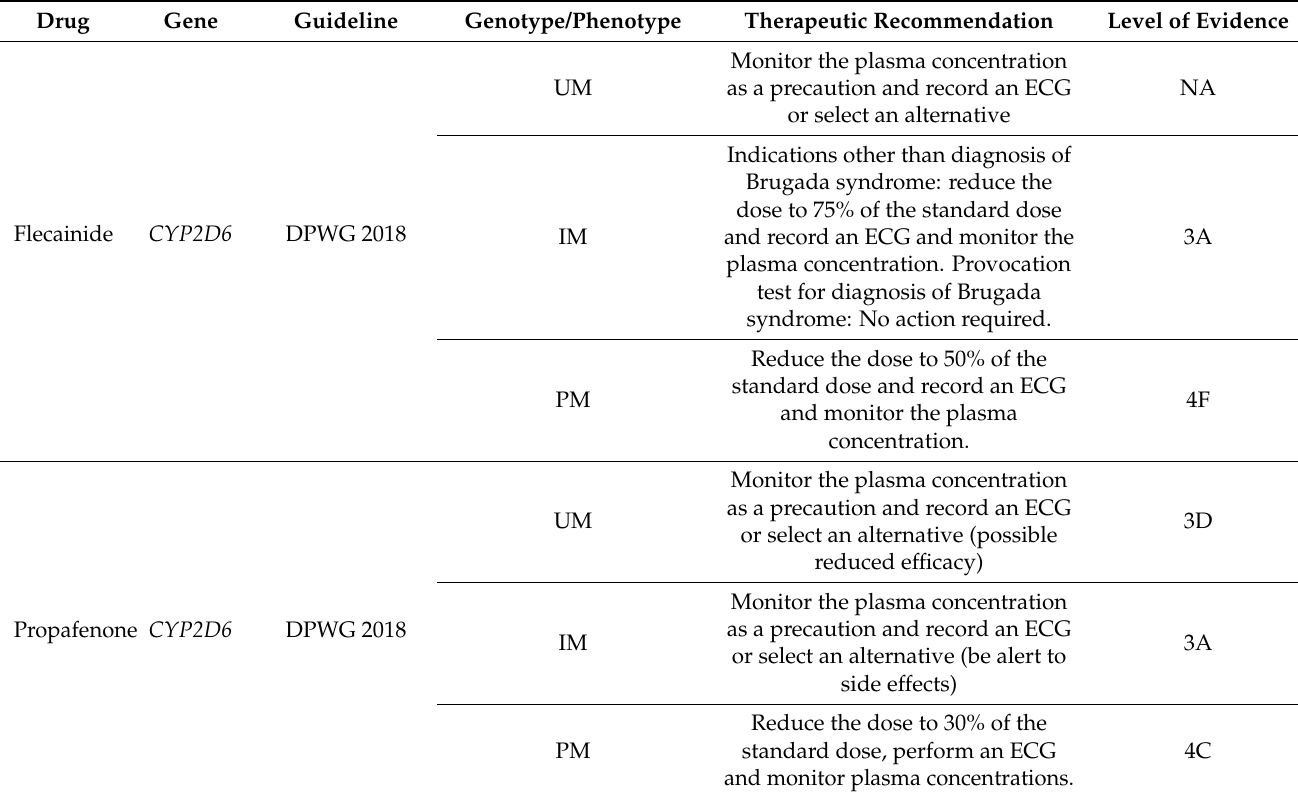
Table 6. Drug-gene pairs and dose recommendations by different clinical guidelines. Antiarrythmics.